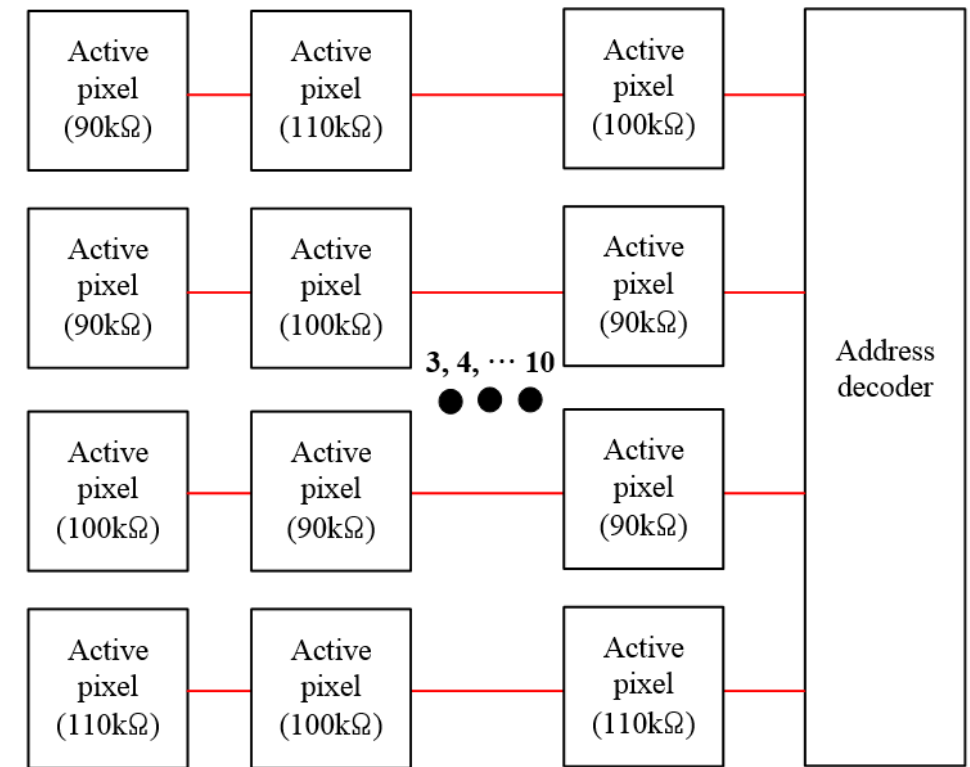
Figure 3. Resistance distribution of the active pixel.